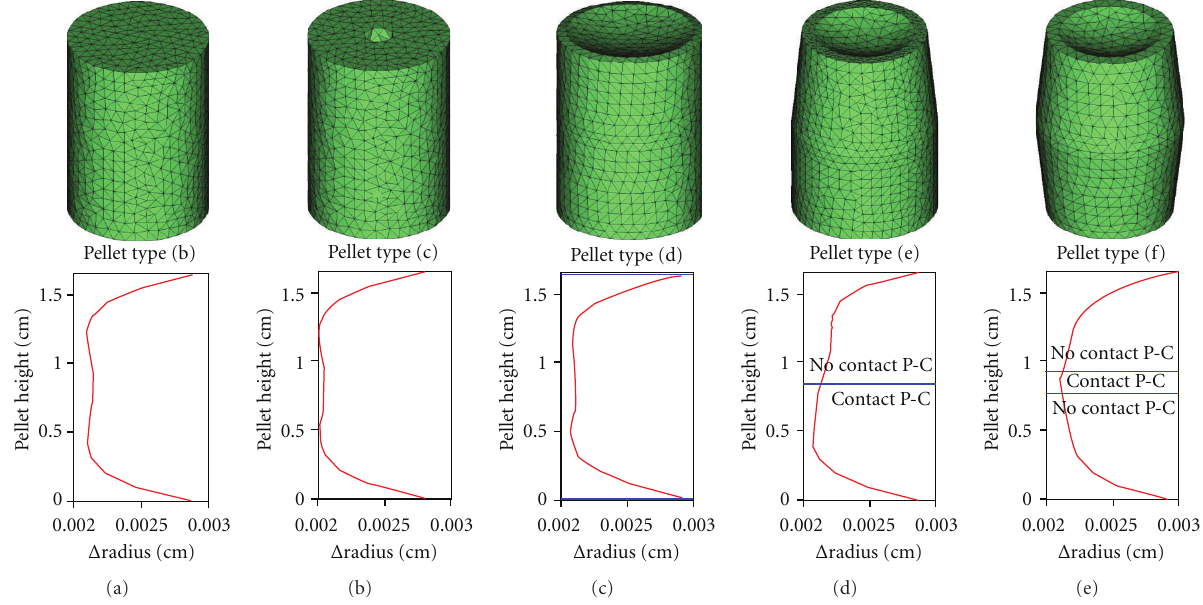
Figure 10: The meshes of experimental CANDU fuel pellets of [1] and their radial deformations. Δ R is the di ff erence between the present radius and the original